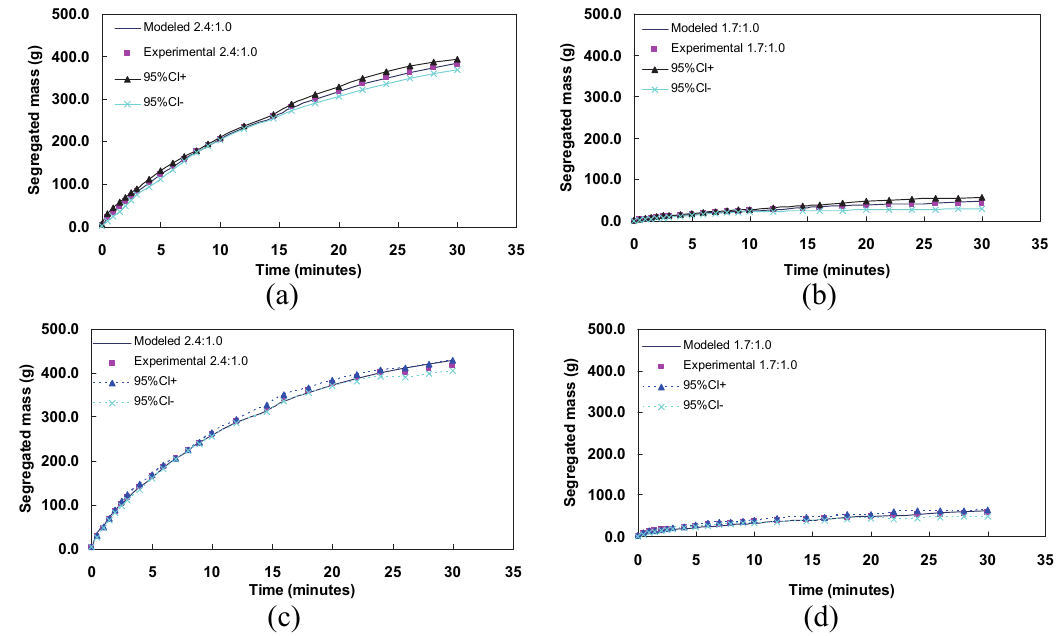
Fig. 3 Modeled and experimental data of potash at strain rate of 0.5 Hz (a) size ratio 2.4:1.0 at strain of 6%, (b) size ratio 1.7:1.0 at strain of 6%, (c) size ratio 2.4:1.0 at strain of 10%, (d) size ratio 1.7:1.0 at strain of